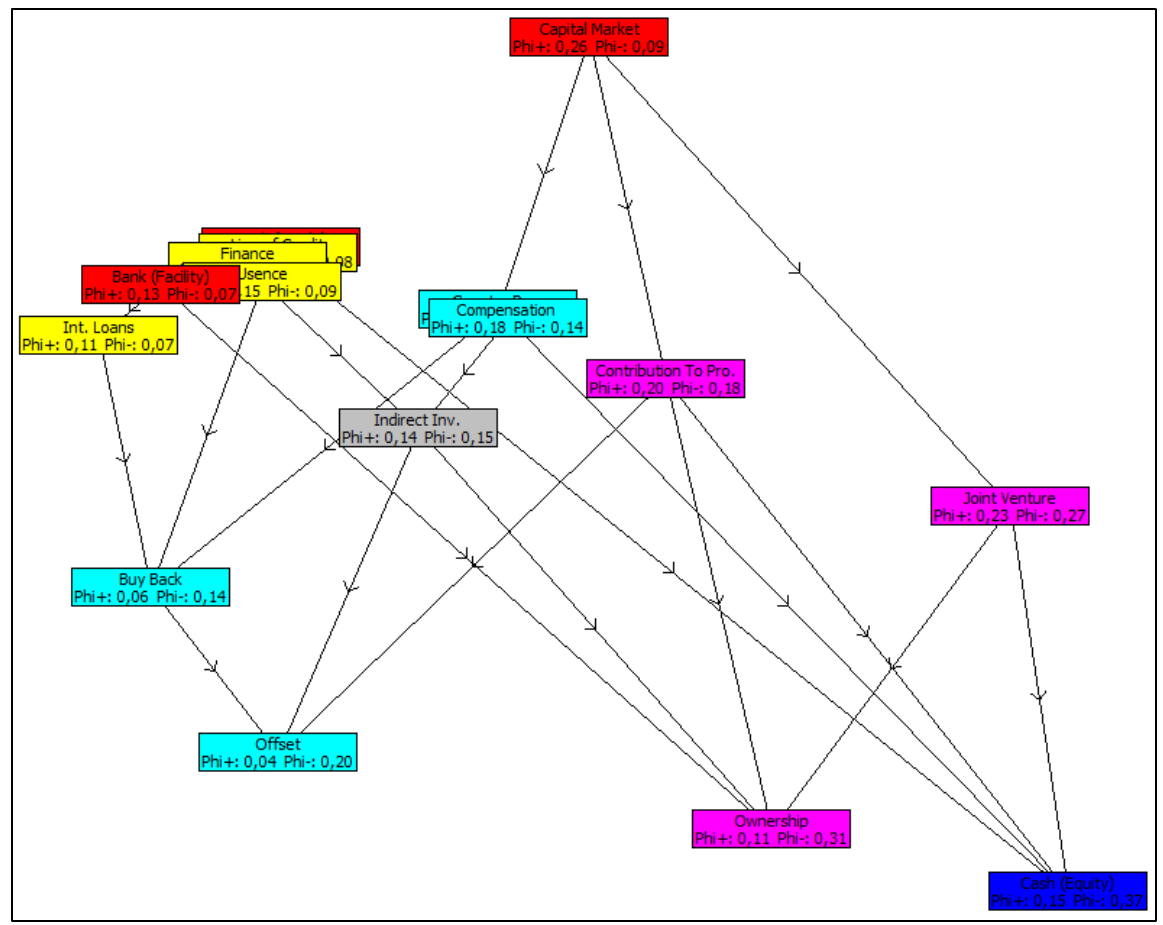
Figure 3 . PROMETHEE